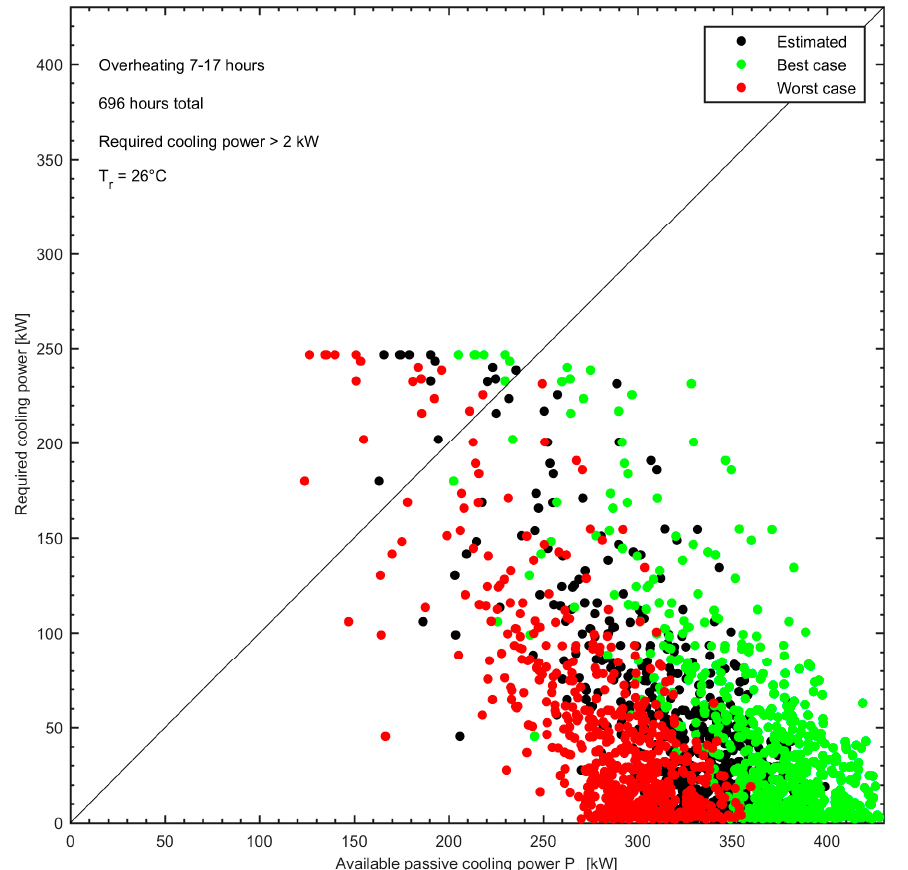
Figure 11. The required and available cooling power P c when utilizing the energy pile foundation at Rosborg Gymnasium for passive cooling.